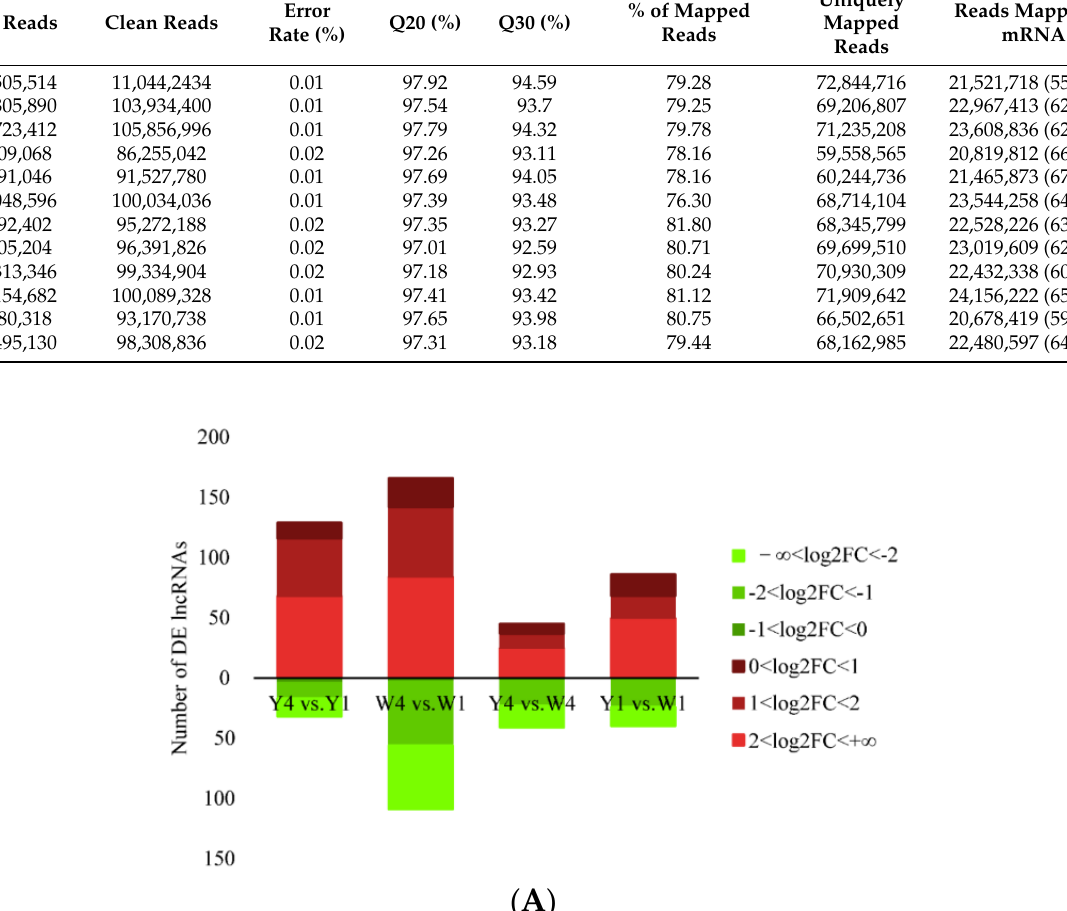
Table 1. Summary of reads filtering, mapping, and counting in RNA-seq.